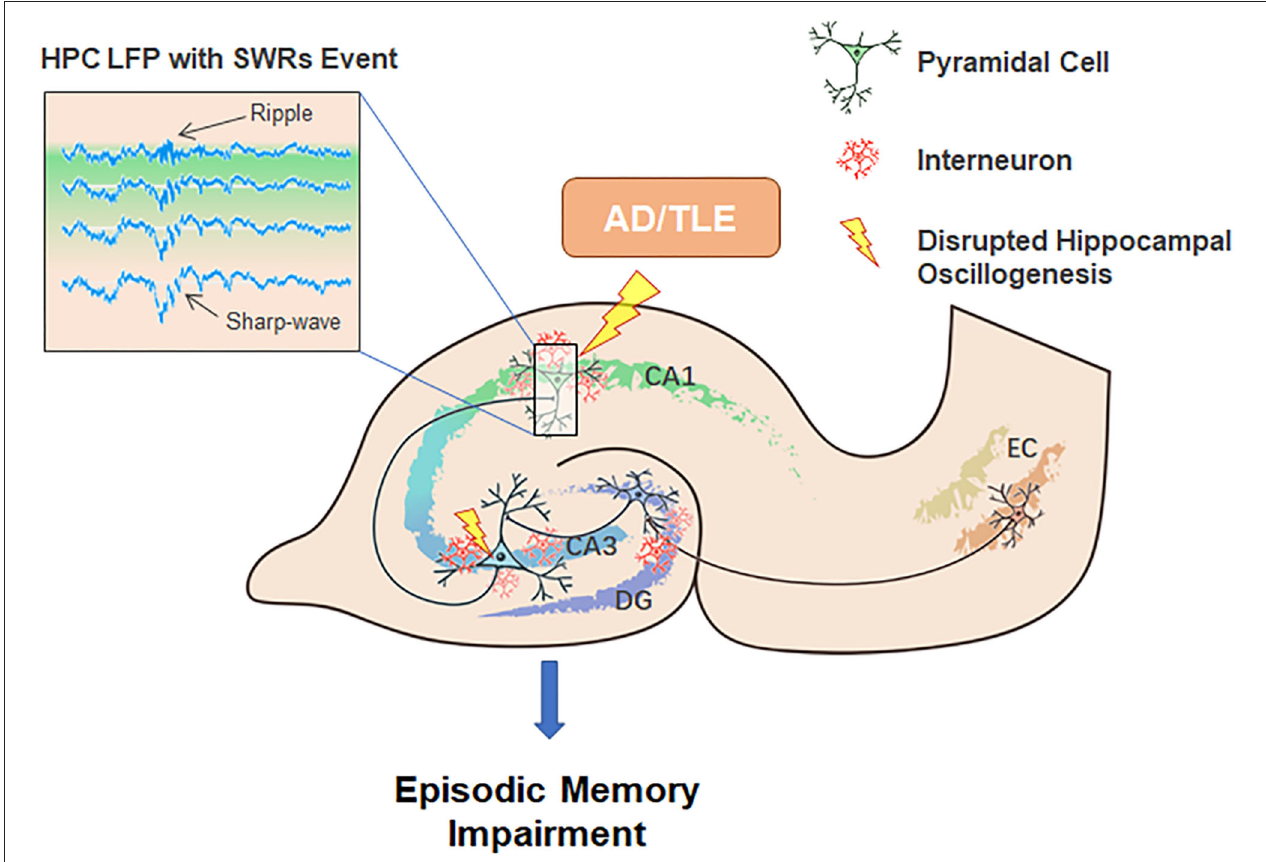
FIGURE 2 | Potential contributions of neuronal network oscillations within the HPC-EC system to episodic memory encoding, consolidation, and the pathogenesis of AD and TLE. Neuronal network oscillations, especially SWRs, are disturbed in AD and TLE.